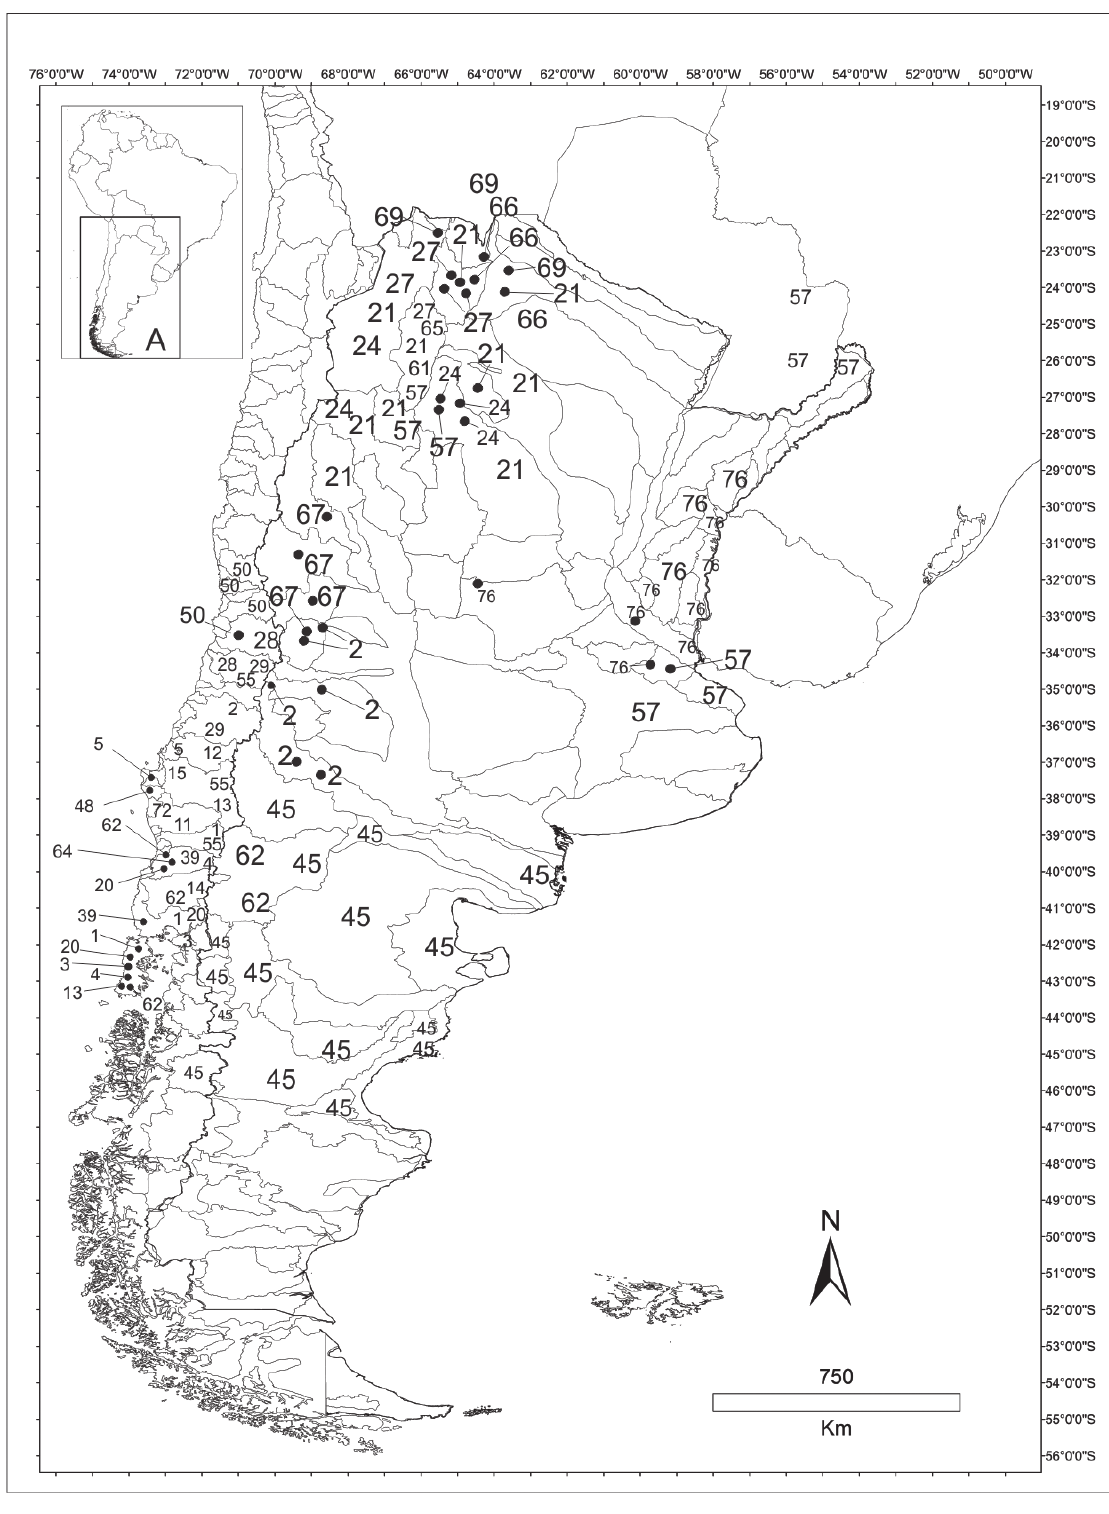
Figure 2. Distribution of Aegla Leach, 1820 in Argentina, Bolivia, Chile, and Paraguay (see Tab. 1 for the corresponding species number). In areas with less species diversity, we used a larger font size to facilitate the localization in the map. However, where diversity is high, to avoid overlapping the numbers, we reduced the font size, and if necessary we used a point with a line indicating the respective